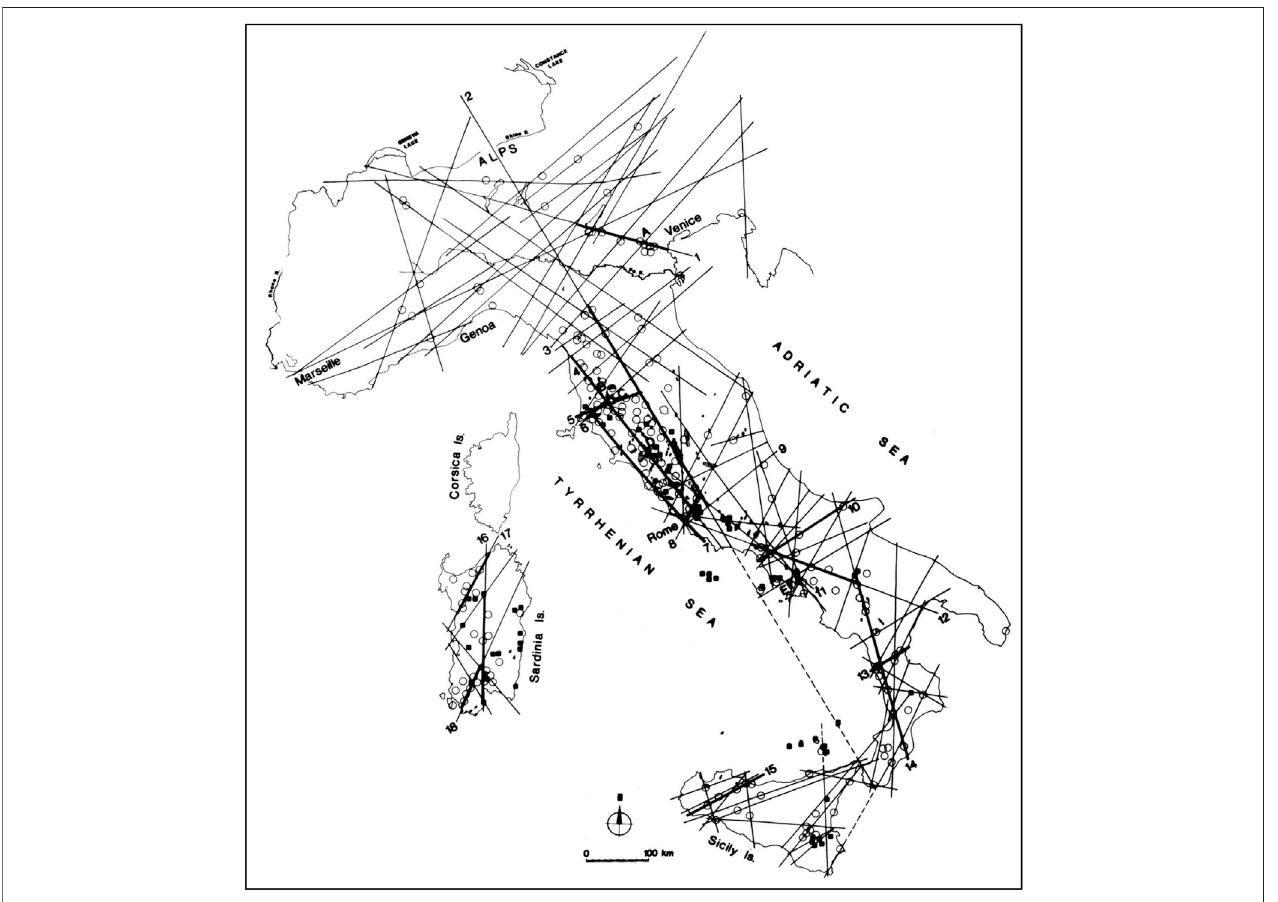
FIGURE 1 | Long lineations detected from ERTS-A satellite imagery compared with the location of thermal springs, shown by empty circles (from Barbier and Fanelli, 1976, modi fi ed). Thicker lines are de fi ned as “ hot lineaments ” as they connect multiple springs. According to the authors of this pioneering study, about 80% of the springs lie on one or more